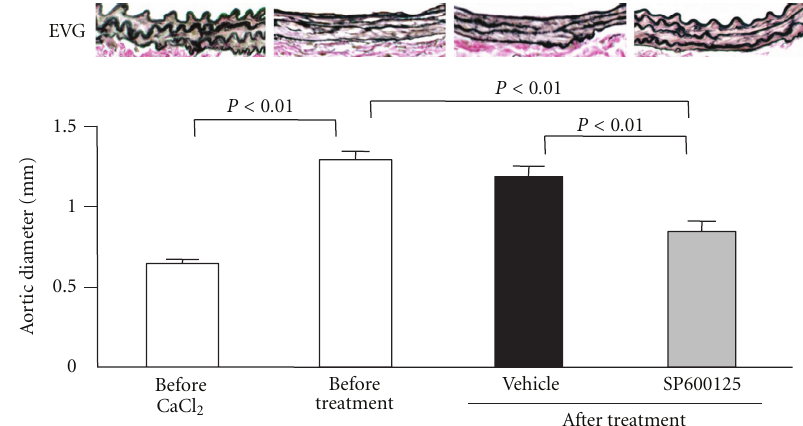
Figure 3: Regression of abdominal aortic aneurysm (AAA) with c-Jun N-terminal kinase (JNK) inhibitor in a mouse model. Six weeks after stimulation of mouse aorta with CaCl 2 , the AAA model was established in association with elastic lamellae disruption and increased aortic diameter. After AAA establishment, pharmacologic treatment with SP600125, a JNK inhibitor, was initiated. After six weeks of SP600125 treatment, there was a significant reduction in aneurysmal size compared with vehicle treatment as well as before treatment. The regression of AAA was accompanied by a repair of tissue architecture. EVG: elastica Van Gieson (modified from Yoshimura et al.